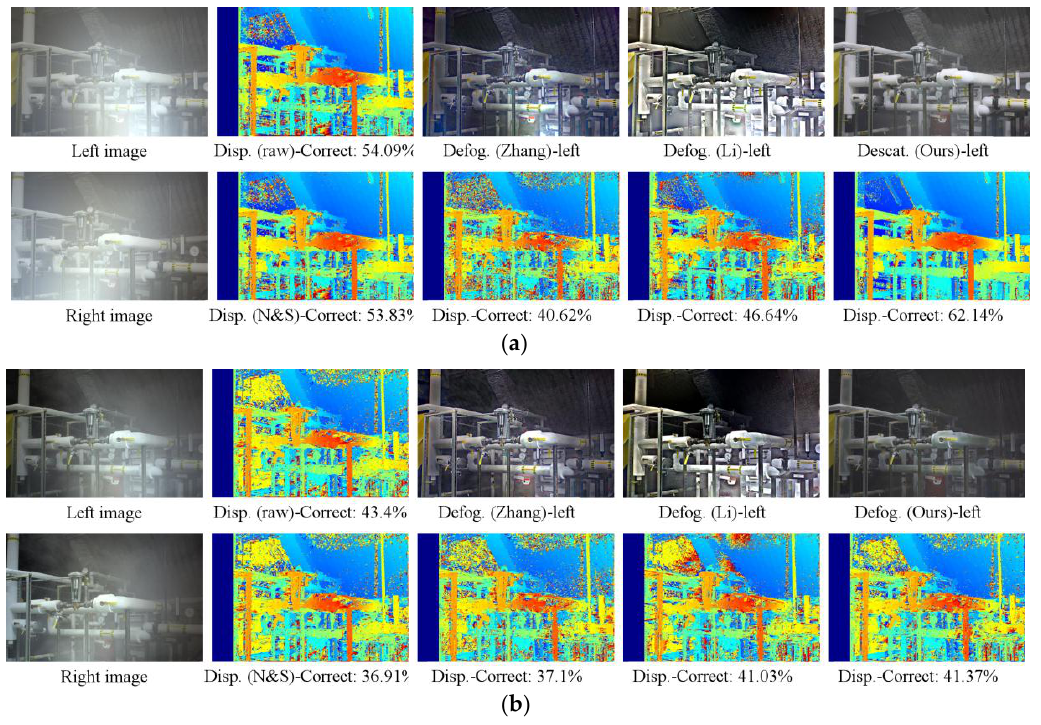
Figure 5. An example of synthetic images of Pipes [9]; the stereo method is NSSD: ( a ) Lighting 1—uniform; ( b ) Lighting 1—non-uniform. The first column is corrupted images. The second column shows the disparity map from input images and the one obtained by using the method in [40]. “N&S” stands for Negahdaripour and Sarafraz [40]. The third to last columns are the defogged (or descattered) images and disparity maps using the methods from [35,36] and the proposed method, respectively. “Disp.” and “Defog.” stand for disparity map and defogged image, respectivley.